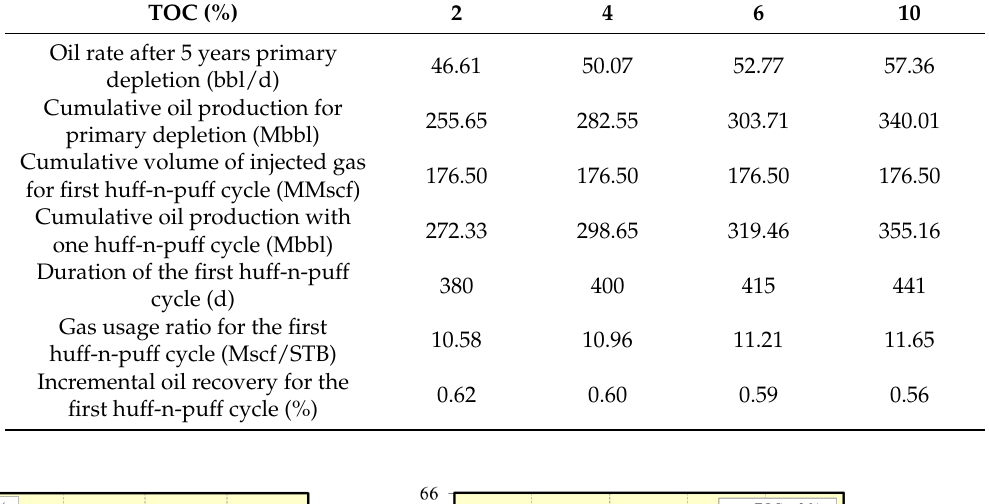
Figure 5. Correlation between reservoir thickness and huff-n-puff results: ( a ) Cumulative oil production and incremental oil recovery for different reservoir thickness; ( b ) Duration of the first huff-n-puff cycle and gas usage ratio for different reservoir thickness. Table 8. Summary of results for huff-n-puff with different TOC.